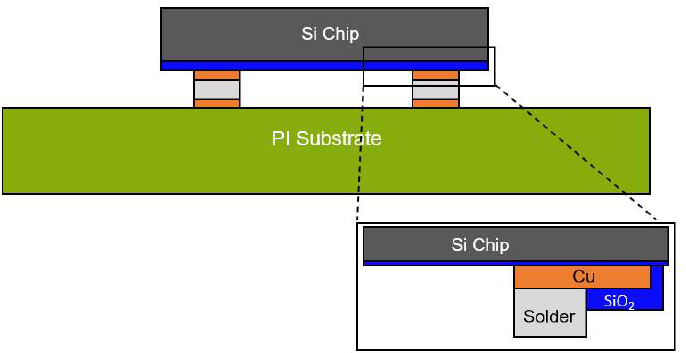
Figure 4. Structure of numerical modeling for the flexible package.